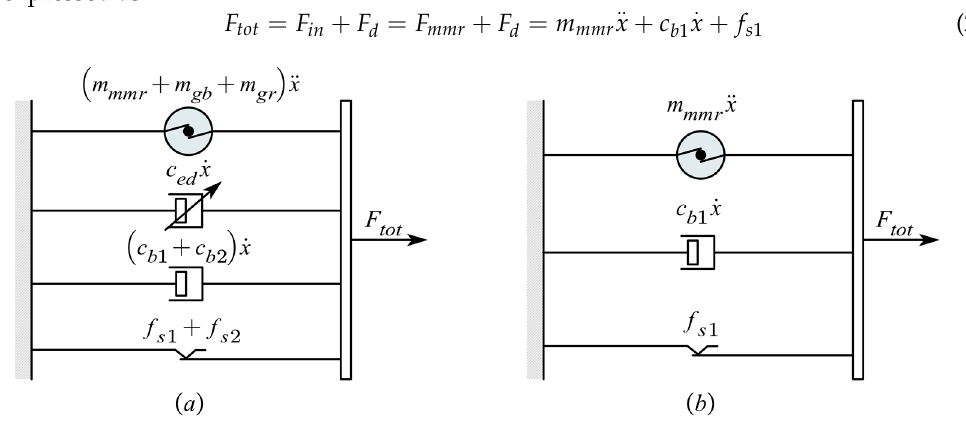
Figure 3. Proposed mechanical models for the MMR − EHSA. ( a ) Engagement model. ( b ) Disengage- ment model.